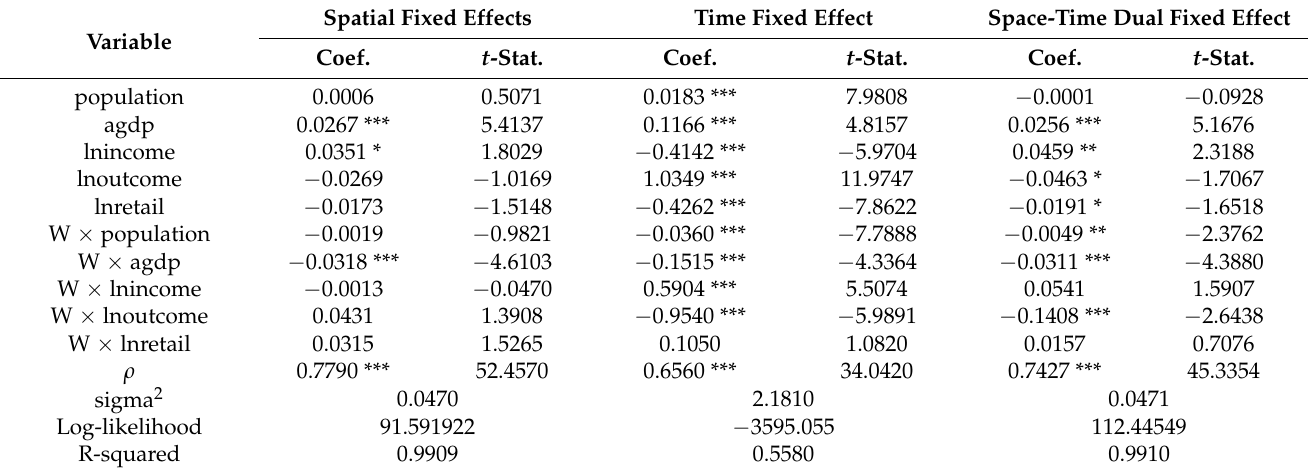
Table 5. Estimation results of the spatial panel Durbin model.